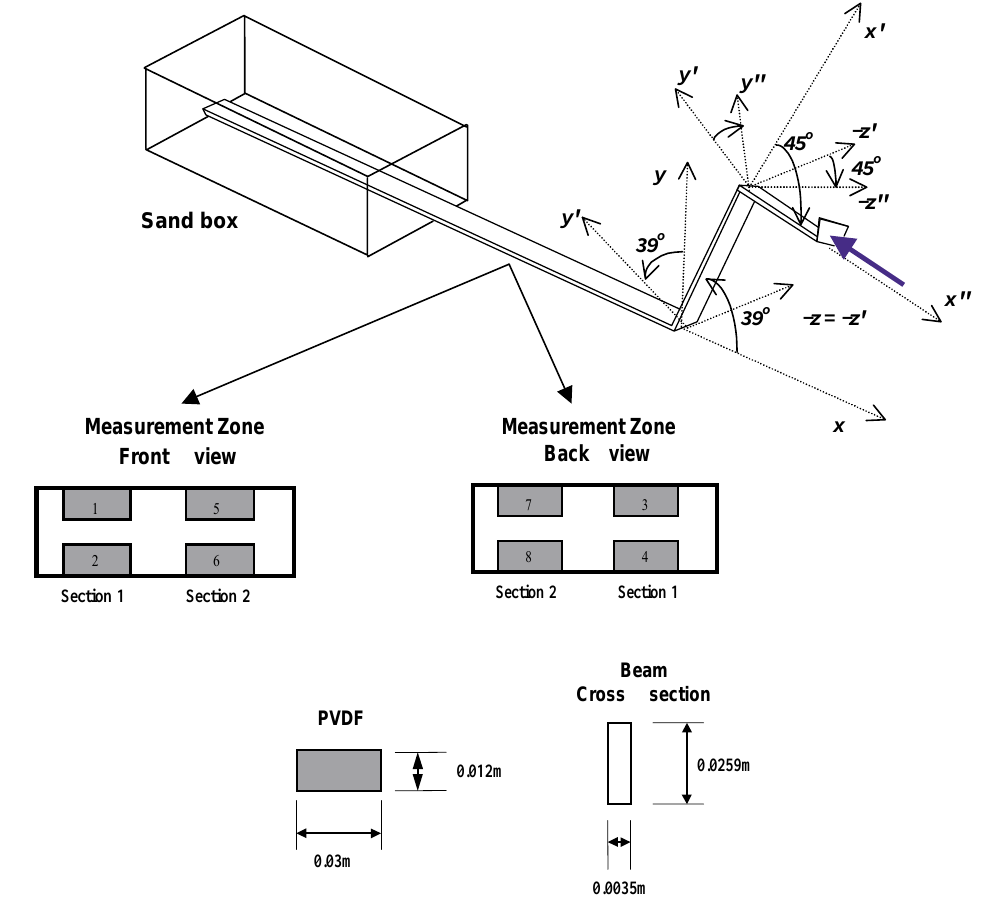
Fig. 1. Z -shaped beam with a quasi-anechoic termination (sand